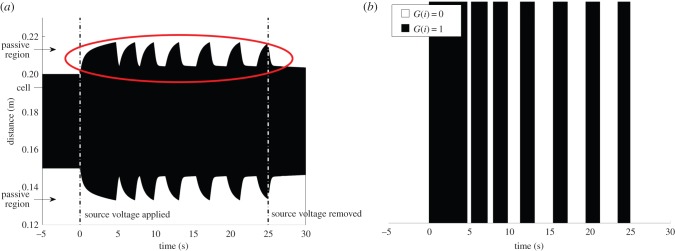
Type I pattern: ‘sawtooth’ oscillatory behaviour, shown circled above, using thresholds of ron = 2.9, roff = 4.2, a cell of natural length 20 mm in the centre of a thread of natural length 50 mm. Source voltage is applied at t = 0 s, and deactivated after 25 s, indicated by dashed lines. (a) View of thread, (b) global state transition diagram. (Online version in colour.)